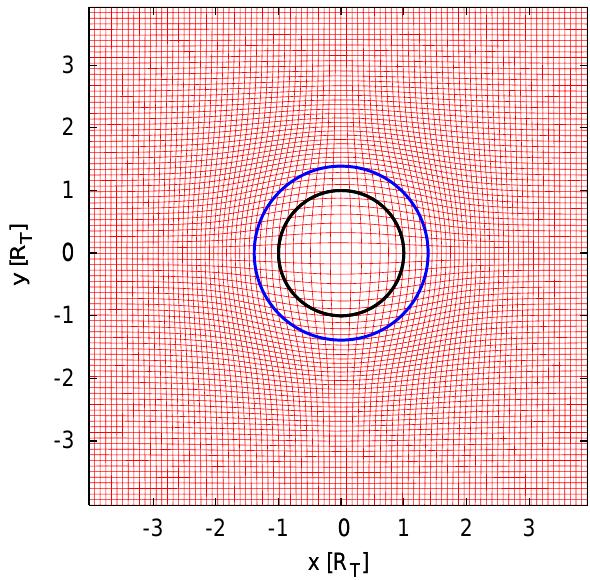
Fig. 4. Curvilinear fisheye simulation grid. In order to avoid the formation of numerical artifacts in the structure of the heavy ion cloud, a curvilinear simulation grid taking account for the spherical symmetry of the obstacle has been used. The inner black circle in the sketch denotes the position of Titan’s surface, whereas the outer one marks the inner boundary of the ionosphere. The fisheye grid is obtained from an equidistant Cartesian grid by means of a coordinate transformation according to Eq. (29). The basic idea is to modify the radial distance of the Cartesian grid points from the center by using a scaling function f (r) . The function f (r) that is utilized to generate the fisheye grid resembles the Fermi-Dirac distribution function. As can be seen from the figure, the major feature of this grid is a region of curved grid lines in the vicinity of the obstacle, whereas with increasing distance to the center of the simulation domain, the grid slightly transforms into a rectangular one. The scaling function f (r) includes three free parameters ( λ , µ and ν ) determining both the curvature of the gird and the location of the region with maximum curvature.